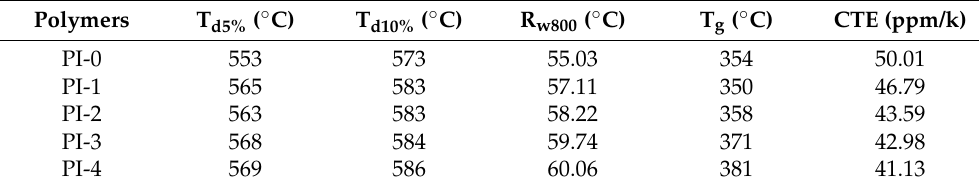
Figure 6. TMA curves of the PI films.